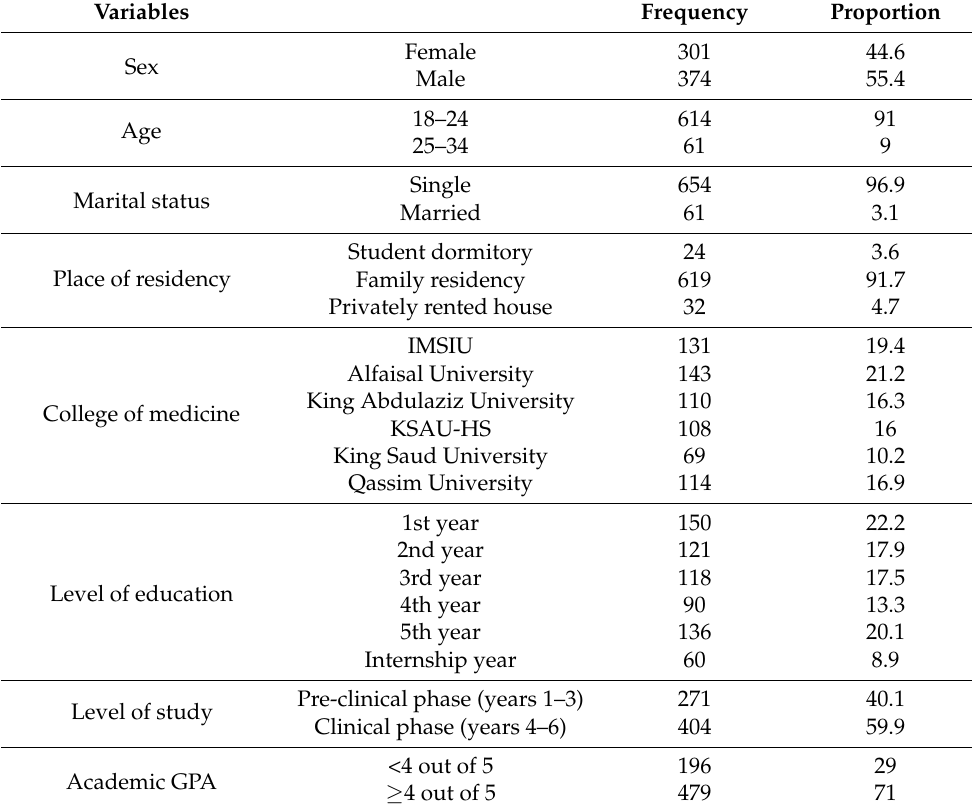
Table 1. The medical students’ sociodemographic and academic characteristics. N = 675.